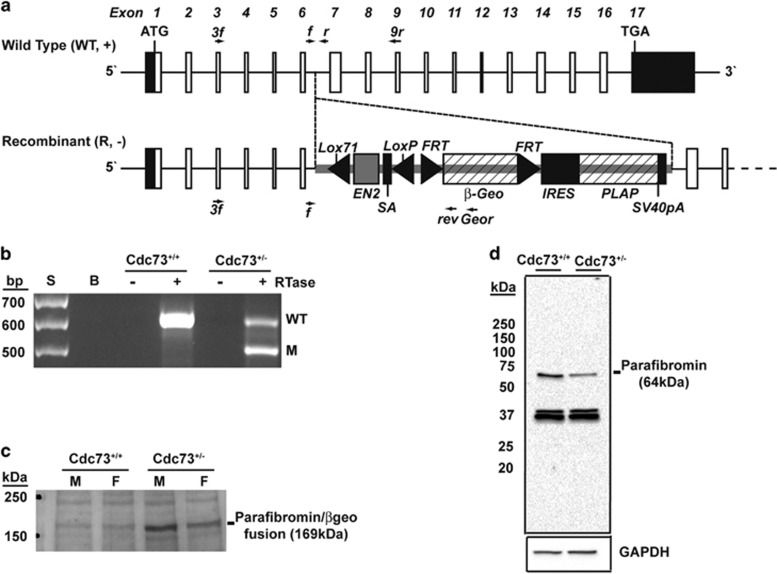
Establishing a conventional Cdc73 knockout mouse model. (a) Schematic diagram of the Cdc73 gene representing the wild-type (WT, +) and recombinant (R, −) alleles. ATG and TGA represent the start and stop codons respectively. The exons are represented by boxes (open boxes depict translated regions), and the domains within the GeneTrap (Gt) vector, incorporated into the R allele, are labelled. The GeneTrap vector in the RRE190 ES cells from BayGenomics22 referred to as Gt(RRE190Byg) is inserted into intron 6 of the Cdc73 gene and subsumes normal splicing of the Cdc73 exon 6 donor site to the GeneTrap Engrailed2 (EN2) acceptor site with loss of exons 7–17. Thus, the parafibromin-β-geo fusion from the first six exons of the Cdc73 gene, would contain only the N-terminal 170 amino acids, which encompasses the nuclear localization signal, and lack the remaining 361 amino acids which will encompass the domains that interact with the Paf1 complex, histone methyltransferase complexes,16 and β-catenin,17 of the wild-type parafibromin. A loss of these critical domains would render the expressed mutant parafibromin non-functional. LoxP (locus of crossing over in phage P1), Lox71 (locus of crossing over 71), FRT (flippase recognition target), SA (splice acceptor of mouse), βGeo (EN2 exon 2, fusion of β-galactosidase and neomycin transferase), IRES (internal ribosome entry site), PLAP (placental alkaline phosphatase) and SV40pA (Simian virus 40 polyadenylation signal). The Lox71, LoxP and FRT sites, located in the GeneTrap vector allow the capability to remove the engrailed intron and β-geo, by breeding with Cre or Flp expressing mice, in order to restore gene function. However, this was not undertaken for this study. (b) Identification of wild-type (Cdc73+/+) and heterozygous (Cdc73+/−) mice by RT–PCR using template RNA extracted from kidneys of adult mice and primers (3 f, 9r and rev). The sizes of the wild-type (WT) and mutant (M) bands are 593 and 500 bp, respectively. (c) Western blot analysis of kidney lysates from adult Cdc73+/+ and Cdc73+/− mice, utilizing an anti-β-geo antibody, revealed the expression of a parafibromin/beta-geo fusion protein (169 kDa) in Cdc73+/− knockout mice only. (d) Analysis of parafibromin expression (64 kDa) using an anti-parafibromin antibody (A300-171A) revealed a 50% reduction in expression assessed by densitometry of band intensity normalized for GAPDH expression (n=4) in Cdc73+/− mice compared to Cdc73+/+ mice; the whole Western blot is shown. The specificity of the anti-parafibromin antibody was validated in HeLa cells transfected with siRNA against CDC73 (Supplementary Figure 1). These results also show that only one form of parafibromin of size 64 kDa and representing the 531 amino acid protein is expressed by Cdc73, despite the reports of of 6 Cdc73 transcripts in the Ensembl database.75 These 6 murine Cdc73 transcripts comprise: transcript 1 which is 11586 bp and encodes a 531 amino acid protein; transcripts 2, 4, 5 and 6 which are 3134 bp, 3056 bp, 2727 bp and 1047 bp, respectively, in length and are processed transcripts or retained introns that do not lead to protein products; and transcript 3 that is 479 bp in length and results in a 73 amino acid protein and subject to nonsense mediated decay. Thus, the observation of only one form of parafibromin of 64 kDa, is consistent with the translation of transcript 1 in the Ensembl database,75 which results in the 531 amino acid parafibromin. The 37 kDa bands, which do not correspond to any translated proteins from the other transcripts, are present with similar intensities in Cdc73+/− and Cdc73+/+ mice (P=0.493, n=4), and are likely to represent non-specific bands. Such non-specific bands, which were not altered by the use of CDC73 siRNA (siCDC73), were also detected in HeLa cells (Supplementary Figure 1). B, blank; F, female; M, male; RTase, reverse transcriptase; S, size marker.